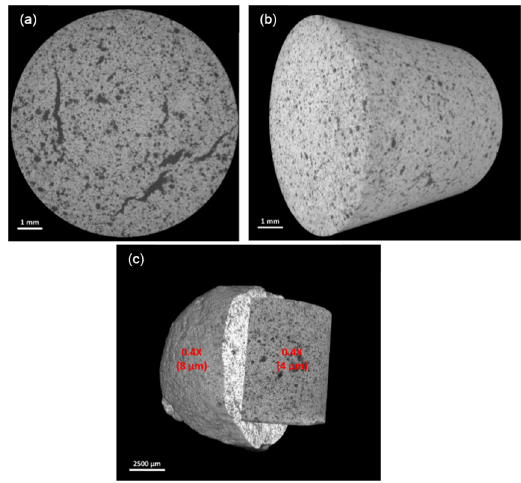
Figure 6. 2 nd Stage of analysis with the 0.4X lens at 4 µm resolution: (a) 2D layer; (b) Corresponding 3D volume; (c) Comparison between analyzed volumes with the same 0.4X lens at different